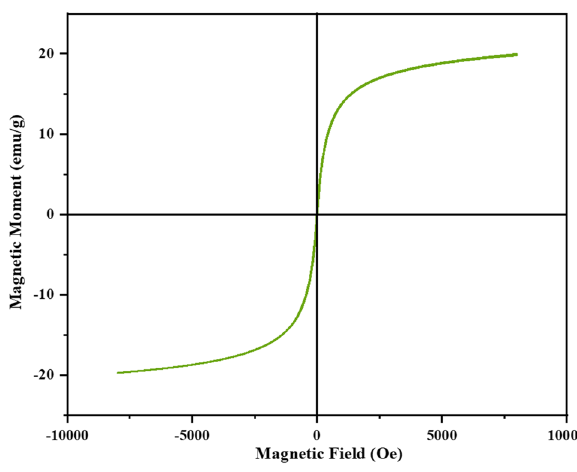
Figure 8. Magnetization curve of Fe-Ben/PVP-DVB/Pd nanocatalyst.